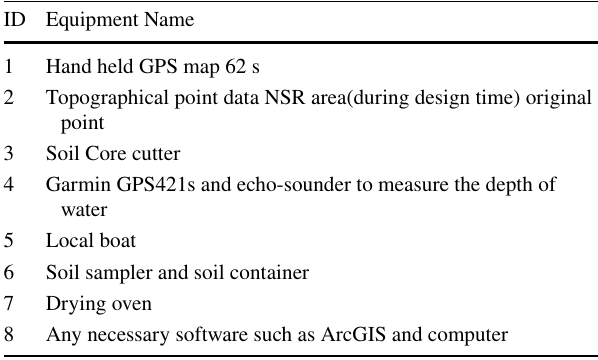
Fig. 1 Map of study area of Adebra NSR Table 2 List of materials used in the NSR bathymetric survey and sediment sampling